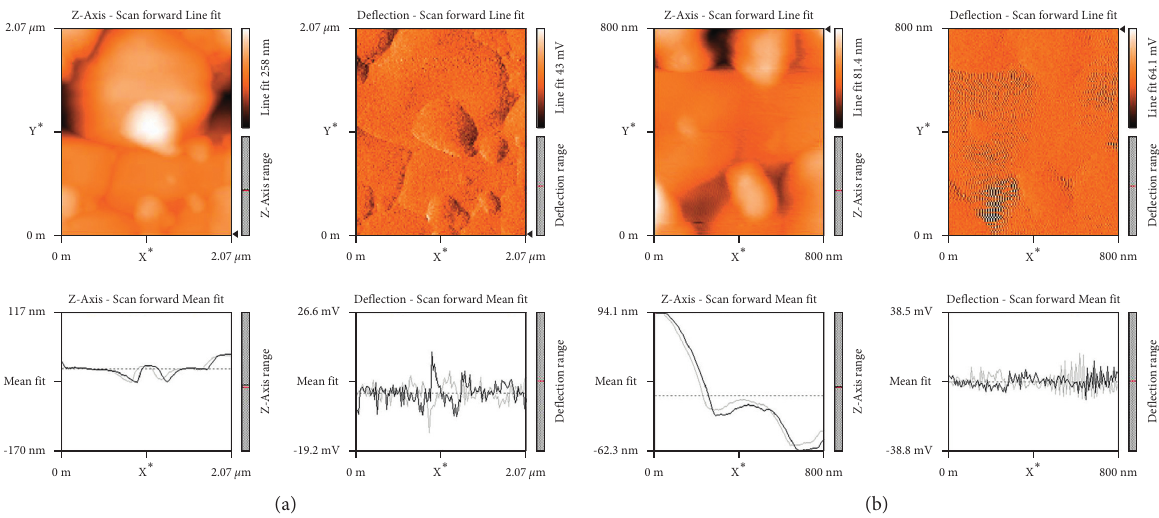
Figure 4: Atomic force microscopy images of copper nanoparticles. (a) 2 μ m and (b) 800nm.